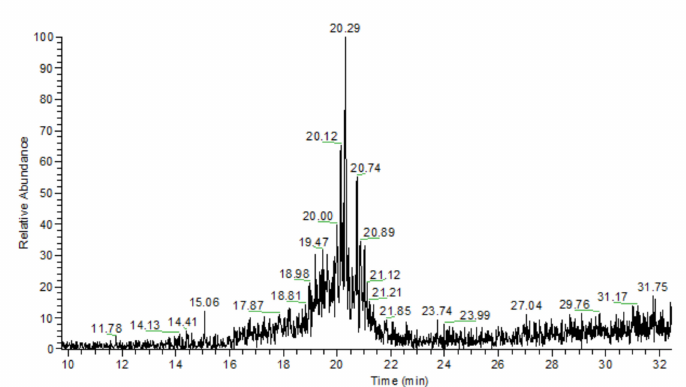
Figure 6. Selected ion ( m/z 143) chromatogram 40 ◦